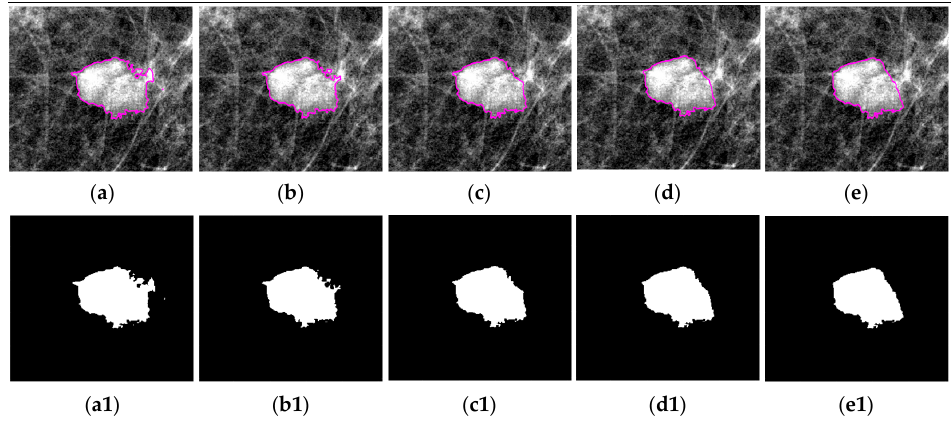
Figure 7. Segmentation Results for SSOMH Model with Different Values of θ .